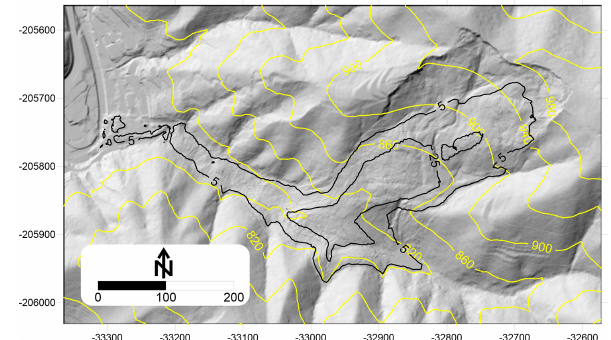
Figure 7. Thickness of the deposit of the Kitamata landslide based on the comparison of the post-DEM including the mixed